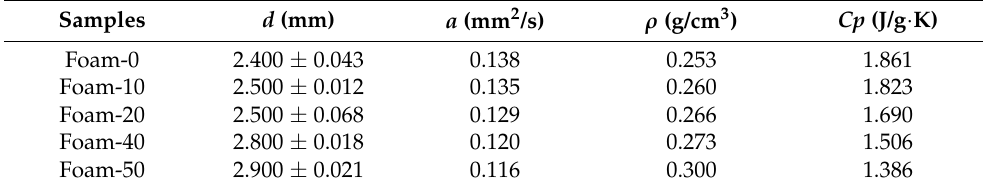
Table 3. The relative parameters of thermal conductivity measured of composite foams. Samples